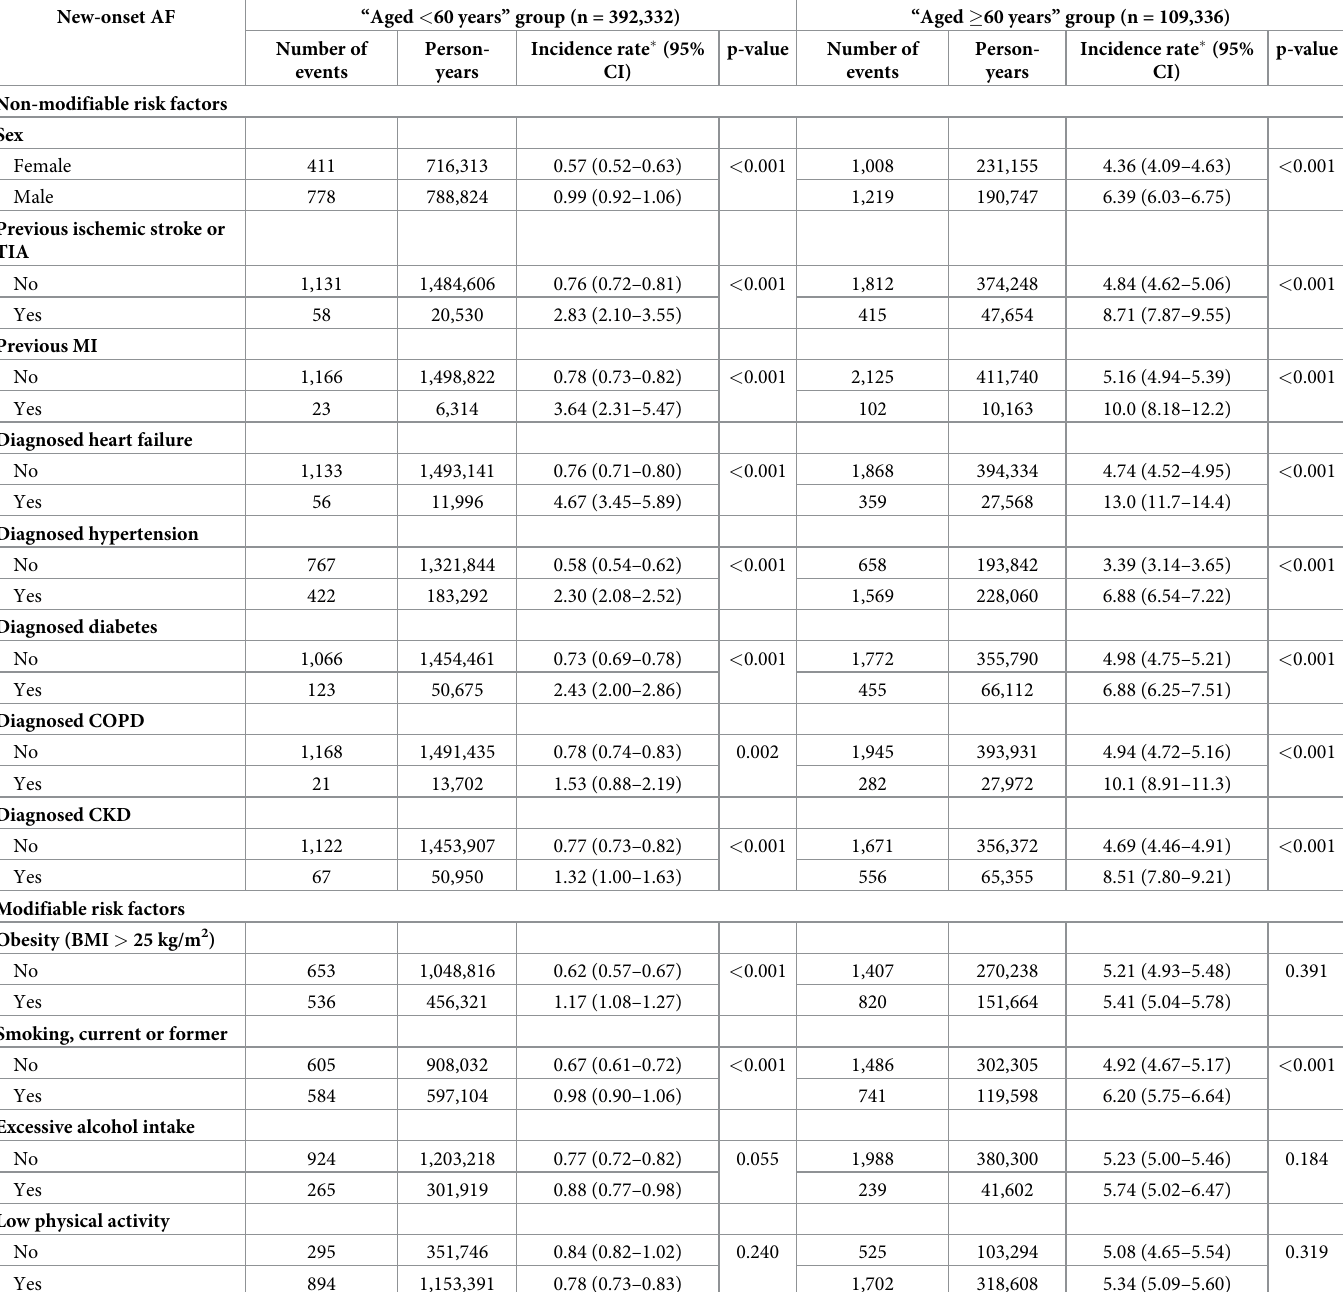
Table 2. The incidence rates of new-onset AF according to risk factors in the “aged < 60 years” and “aged � 60 years” groups. New-onset